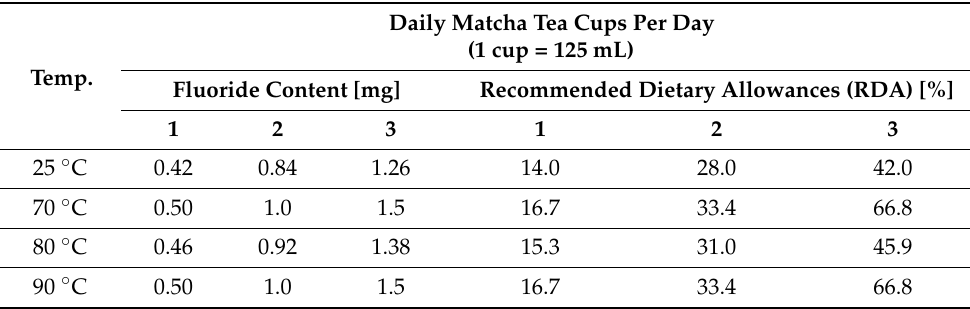
Table 4. The concentration of fluoride in daily matcha infusions depending on the water temperature and the percentage of the Recommended Dietary Allowance (RDA) for the diet.